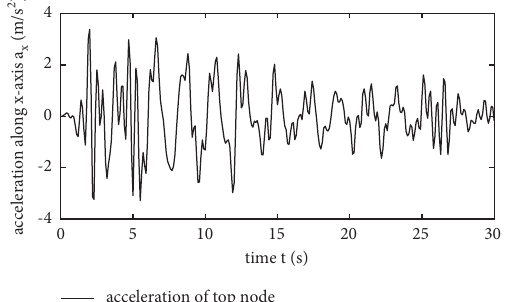
Figure 9: Acceleration of top node (o) along the